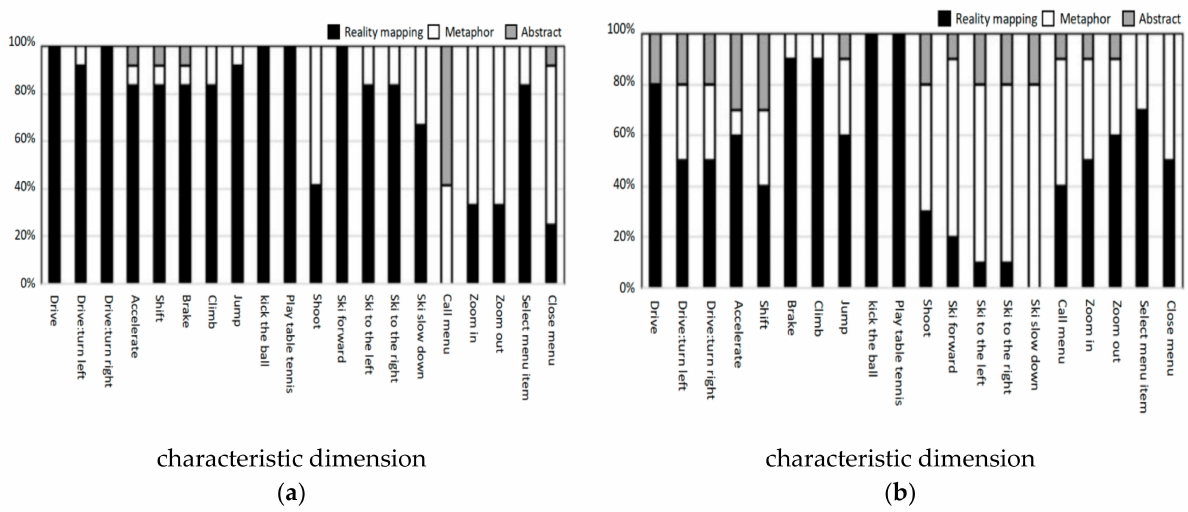
Figure 7. ( a ) Action distribution of young group in the characteristic dimension; ( b ) action distribution of elderly group in the characteristic